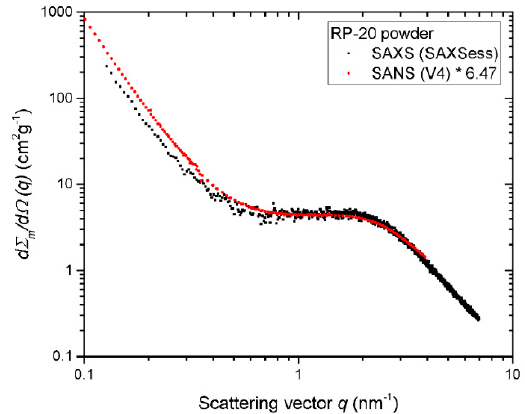
Figure8. ComparisonoftheRP-20carbonmeasuredbySAXSonaSAXSess(AntonPaar)(blacksymbols) and SANS at the small-angle scattering instrument V4 (cold neutron guide of Helmholtz-Zentrum Berlin—BER II) (red symbols). The SAXS data shown are scaled by the contrast factor 6.47. The corrected SAXS data from Figure 1 and SANS data were normalized to mass as indicated in Equation